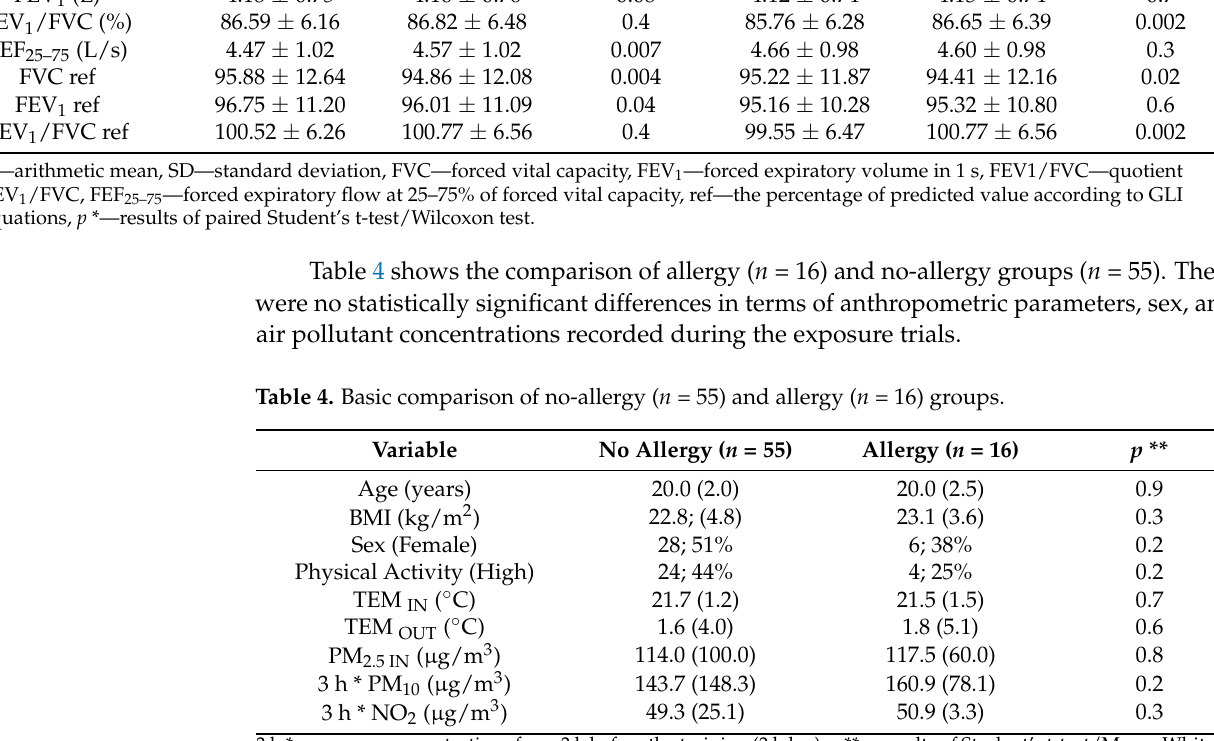
values and ‘number; percentage’ for qualitative values. Comparison of post-exercise changes in spirometry parameters (relative differences) between exposure and control trials separately for the no-allergy and allergy groups is significant differences. Only in the allergy group did FEV 1 /FVC increase statistically significantly more during control trials than during exposure trials. Table 5. Comparison of post-exercise changes in spirometry parameters (relative differences) between exposure and control trials for no-allergy ( n = 55) and allergy ( n = 16) groups. Relative Difference (%) between Post-Exercise and Baseline Measurements Variable